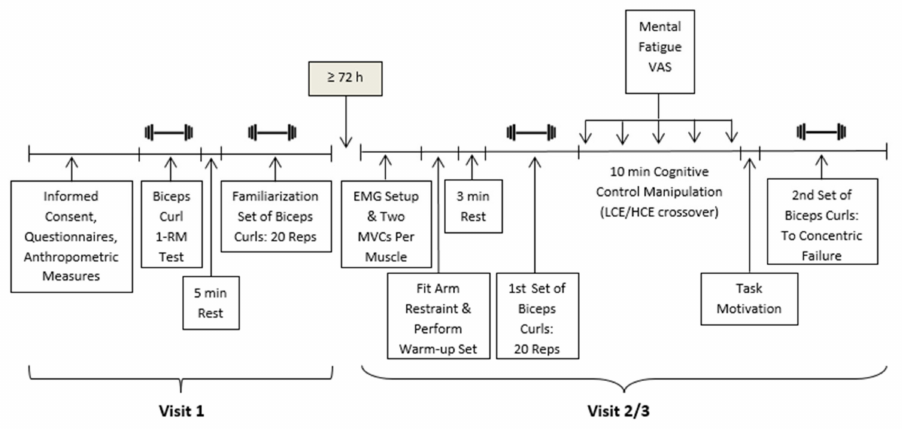
Figure 1. Experimental protocol